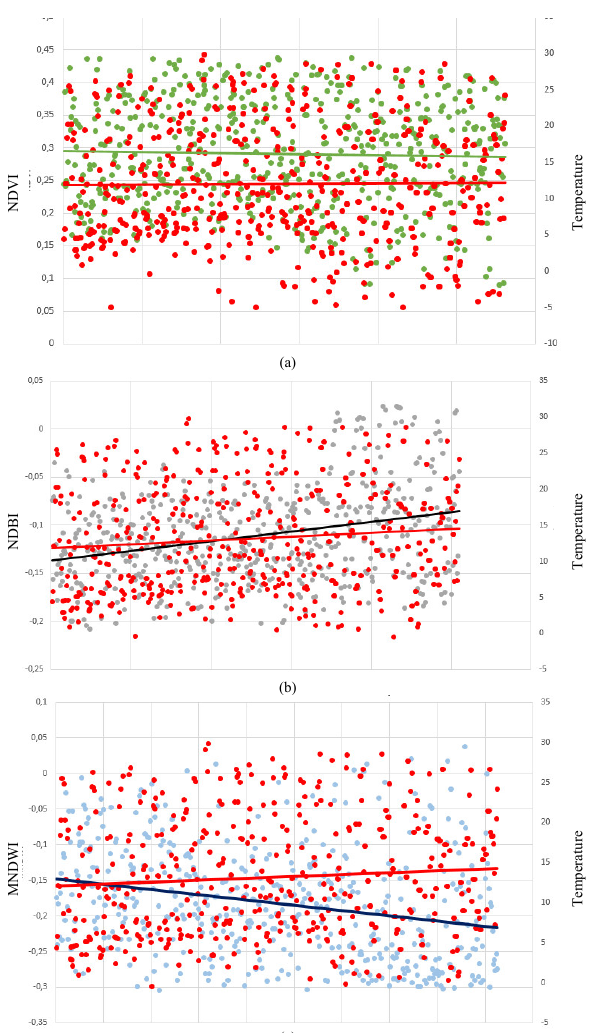
Figure 3. Statistical visualization of mean values acquired based on Landsat imagery during the 30 years for the city of Tokyo. (a) Relationship between temperature and NDVI, (b) the relationship between temperature and NDBI and (c) the relationship between temperature and